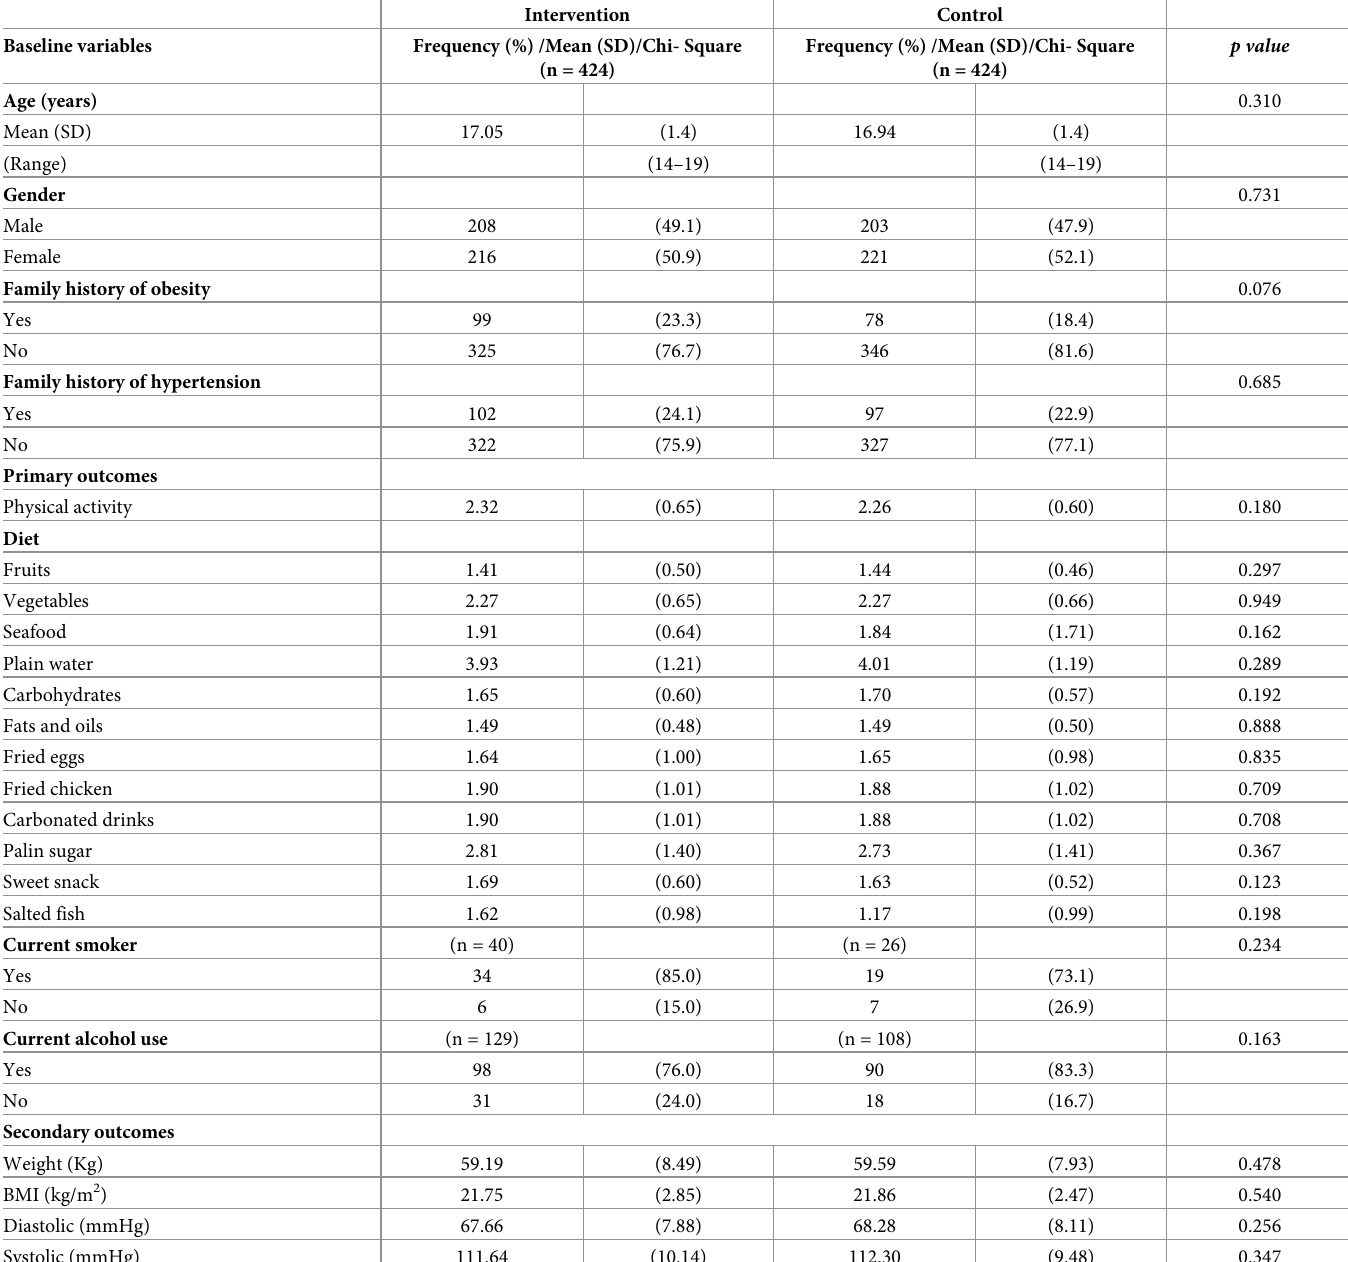
Table 2. Baseline comparison between intervention and control